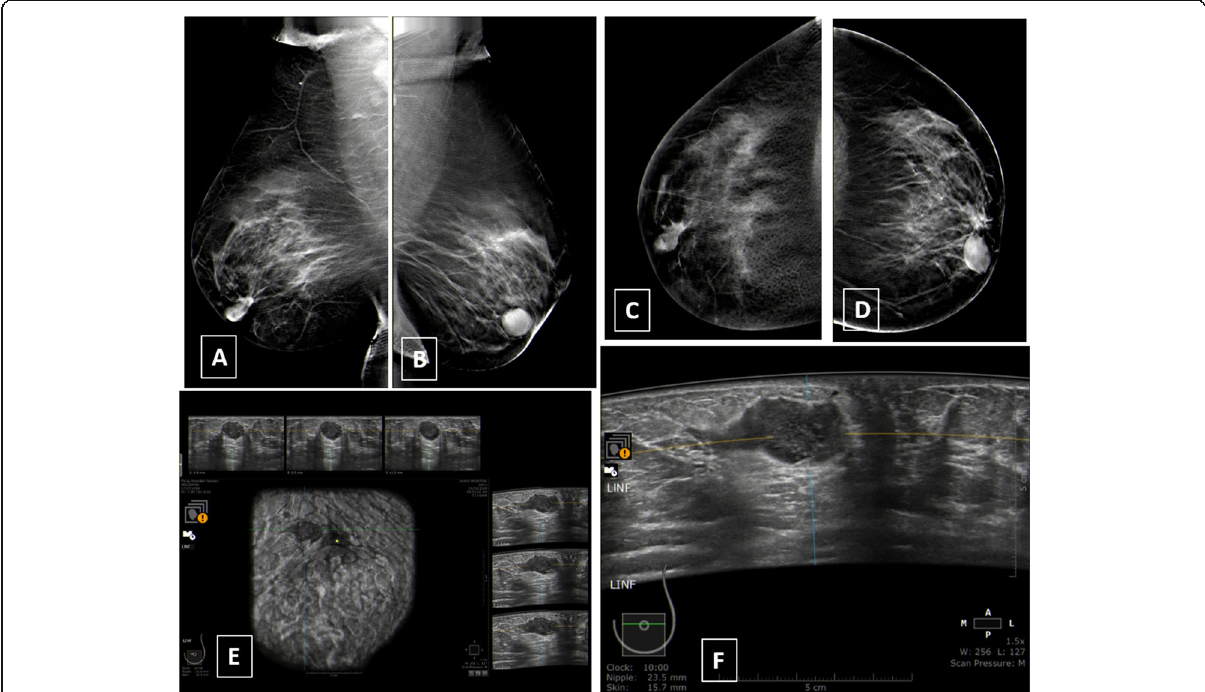
Fig. 3 Case three: 39-year-old with left breast lump. Recent history of right breast abscess drainage. Youngest child 18 months old. A - D 3D Tomo slices of both breasts in MLO and CC views showing bilateral retro areolar densities with partially obscured margins. E , F Multiplanar ABUS images showing cystic nature of the masses with intraductal echogenic secretions. Chronic galactocele